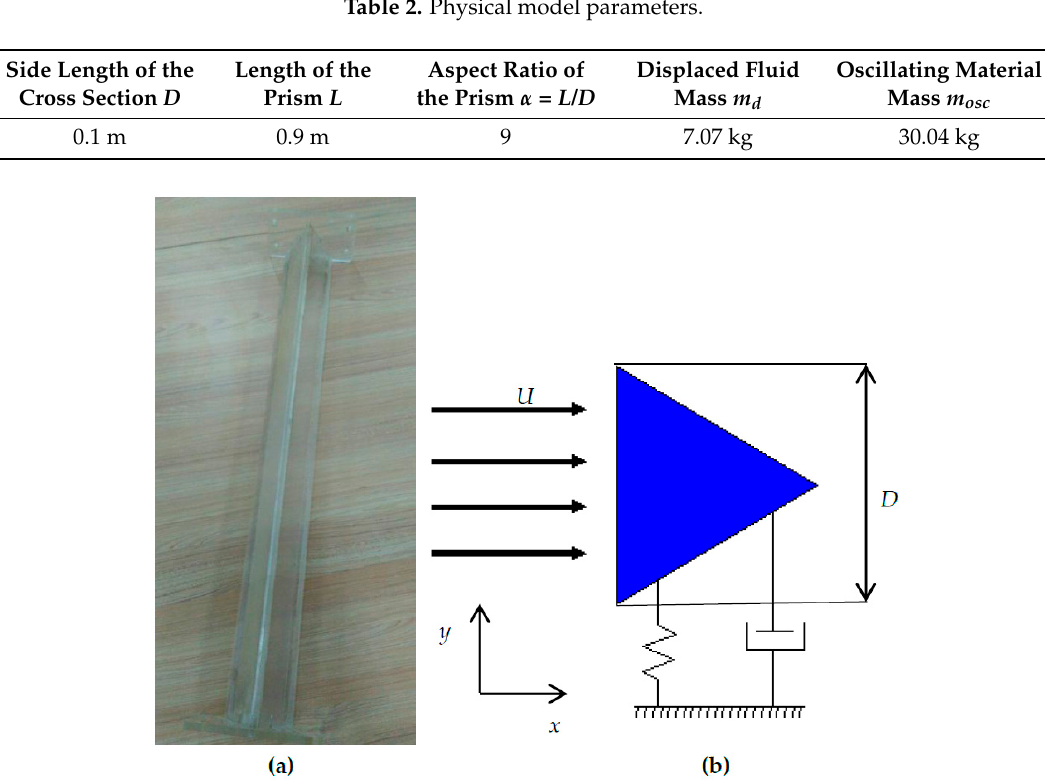
Figure 2. Oscillator ( a ) Equilateral triangle prism; ( b ) Installation way of the equilateral triangle prism in the